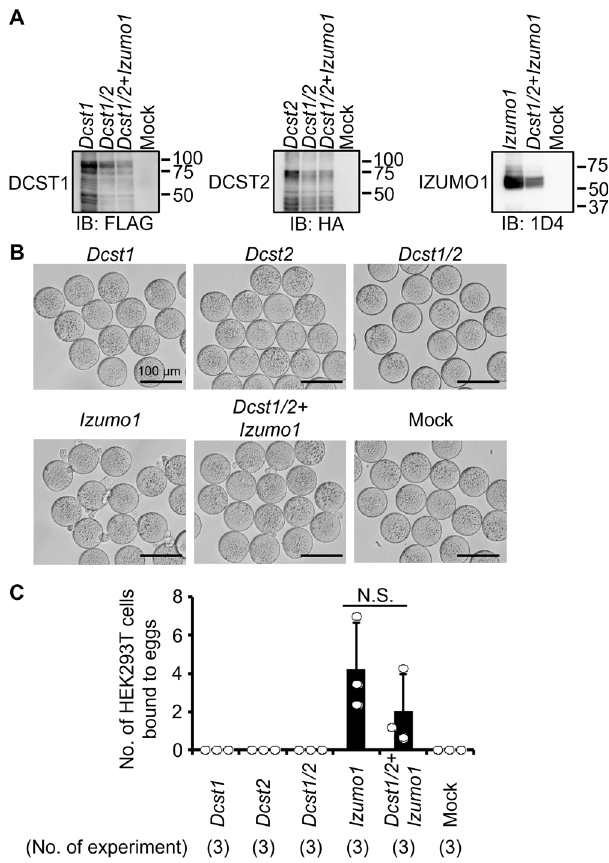
Fig. 4 Binding assay between ZP-free eggs and HEK293T cells overexpressing Dcst1/2 . A Detection of DCST1/2 and IZUMO1. FLAG- tagged DCST1, HA-tagged DCST2, and 1D4-tagged IZUMO1 were detected in HEK293T cells overexpressing Dcst1 -3xFLAG, Dcst2 -3xHA, and Izumo1 - 1D4. B , C Observation of ZP-free eggs incubated with HEK293T cells overexpressing Dcst1/2 and Izumo1 . The HEK293T cells overexpressing Dcst1 or Dcst2 did not attach to the oocyte membrane. Even when the HEK cells overexpressing Dcst1/2 were used for the assay, these cells failed to bind to ZP-free eggs. The HEK293T cells overexpressing Dcst1/2 and Izumo1 could bind to the oocyte membrane but could not fuse with an egg. n.s.: not signi fi cant ( p = 0.28). The scale bars are 100 μ m. All values are shown as the mean ± Dcst1 -3xFLAG and Dcst2 -3xHA in HEK293T cells revealed the